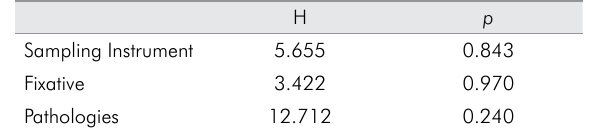
Table 4. H and p values from the Kruskal-Wallis test com- paring the different fields of practice/specialties and the variables of sampling instrument, fixative and pathologies for which EC is